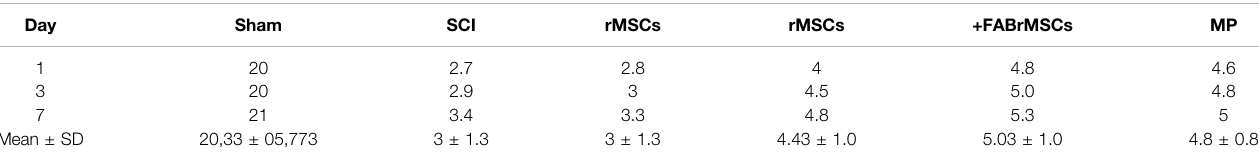
TABLE 2 | Comparison between BBB scores. Data are expressed as means ± SD.